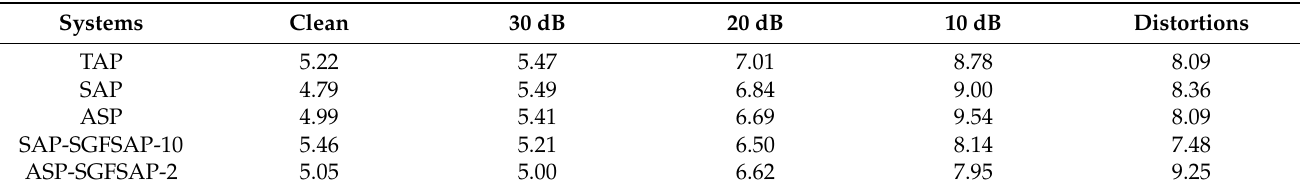
Table 2. The experimental results on TIMIT under different SNR levels and typical